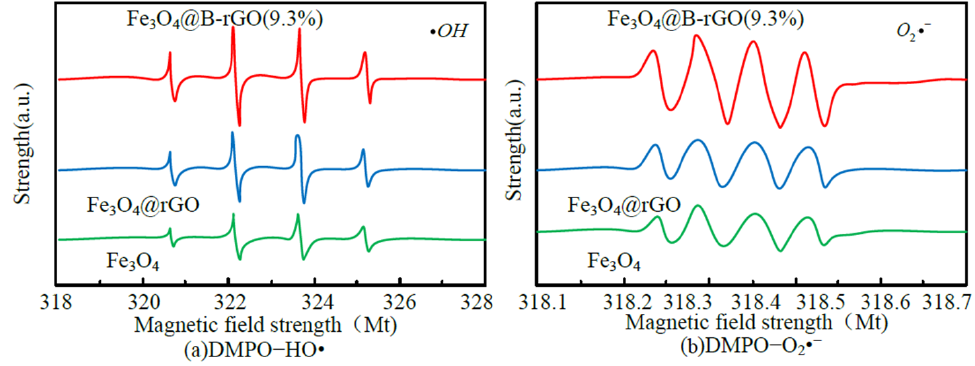
Figure 9. Electron spin resonance spectra of DMPO − HO• ( a ) and DMPO − O 2 • − ( b ) adducts in visible-light Fenton system of different catalysts.